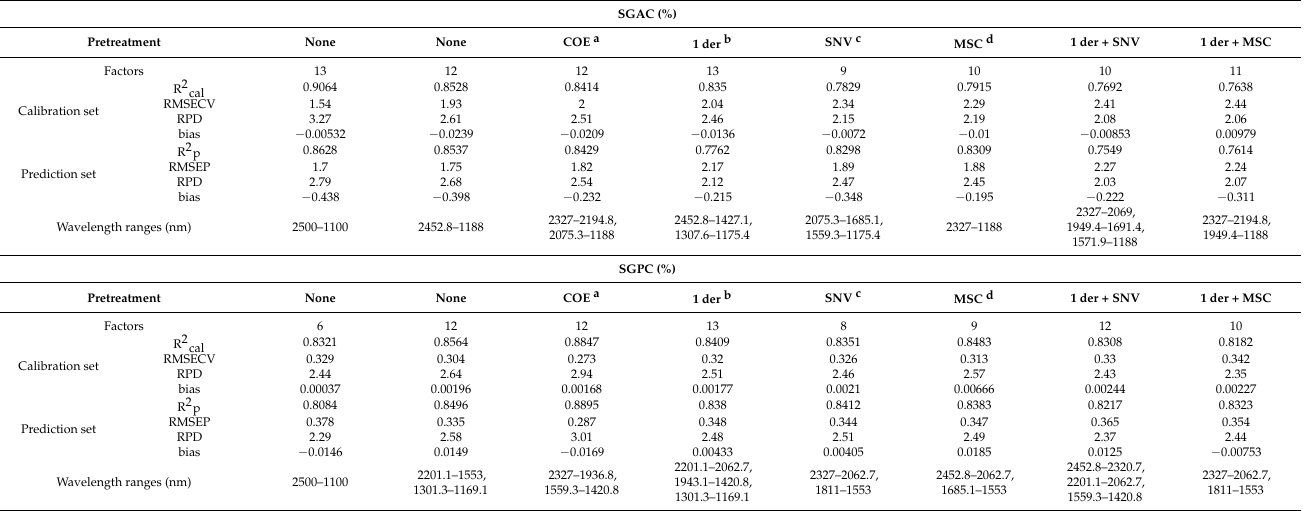
Table 2. Analysis of partial least squares models of rice single-grain amylose content (SGAC) and single-grain protein content (SGPC) using different pretreatments and spectral